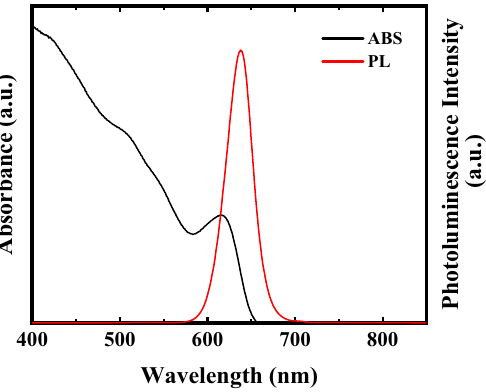
Figure 5. Absorption and photoluminescence spectra of CdSe/ZnS core–shell QDs.